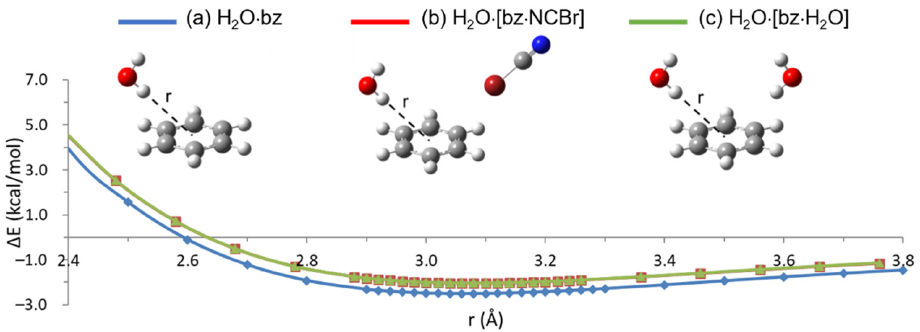
Figure 4. Binding energy curves, ∆ E, vs. (HO)H distance from the center of benzene ring, r, computed for ( a ) H 2 O · bz (blue line), ( b ) H 2 O · [bz · NCBr] (red line), and ( c ) H 2 O · [bz · H 2 O] (green line) systems in the perpendicular approach at the M06-2X/aug-cc-PVTZ level of theory.